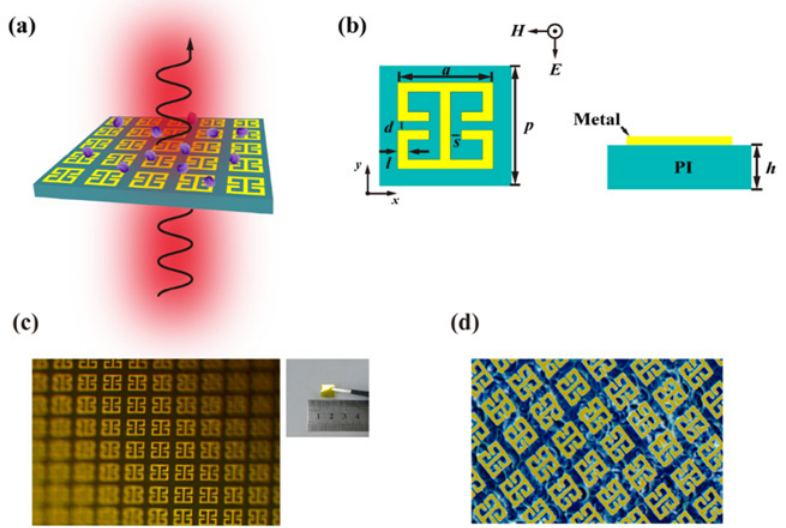
Figure 16. ( a ) A schematic of a plasmonic metasurface (PMS)-based transmission-type biosensor comprised of periodic split-ring resonator (SRR) unit cells, with the incident THz waves propagated through PMS from the bottom dielectric to top metal layer. ( b ) Top view (left) and side view (right) of the unit cell, respectively. The structural parameters: a = 36 µm; l = 4 µm; d = 3.5 µm; s = 4 µm; and h = 10 µm. ( c ) In the micrograph of the fabricated PMS sample, the 1 cm × 1 cm biosensor is given in the inset. ( d ) A color-enhanced micrograph of PMS covered with HSC3 cells. Reprinted from [176].